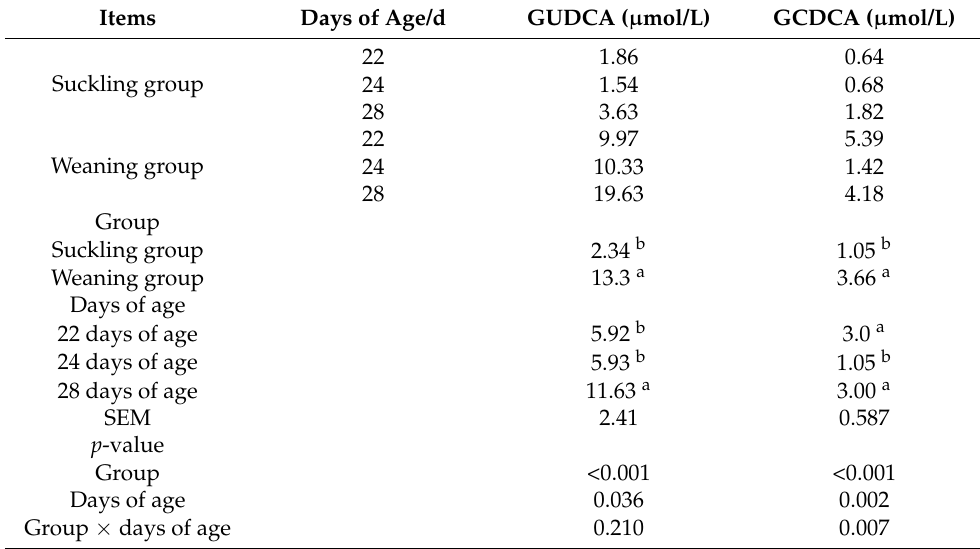
Table 4. Effects of weaning at 21 days of age on Glycine-conjugated BAs of cecum